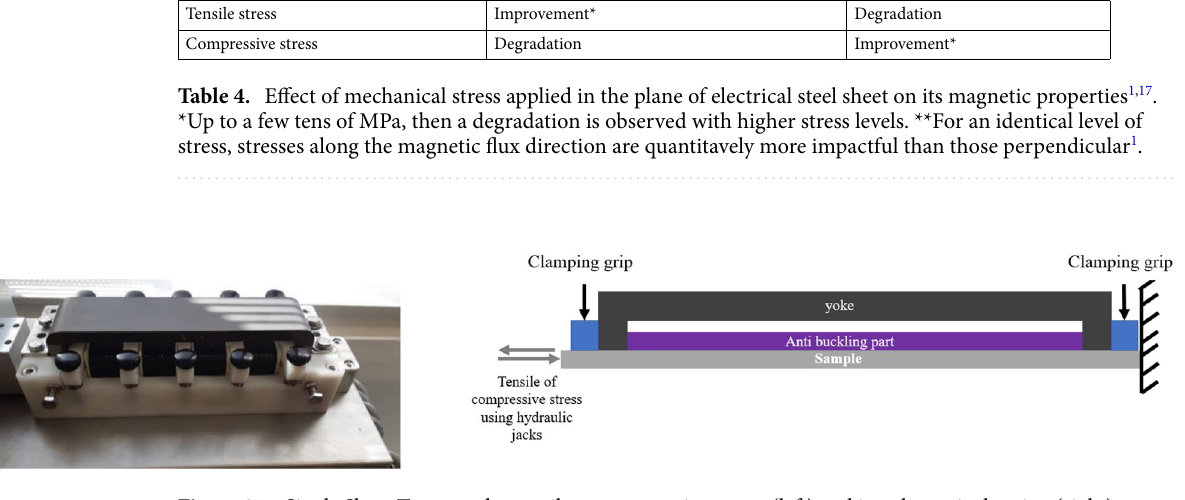
Figure 25. Single Sheet Tester under tensile or compression stress (left) and its schematic drawing